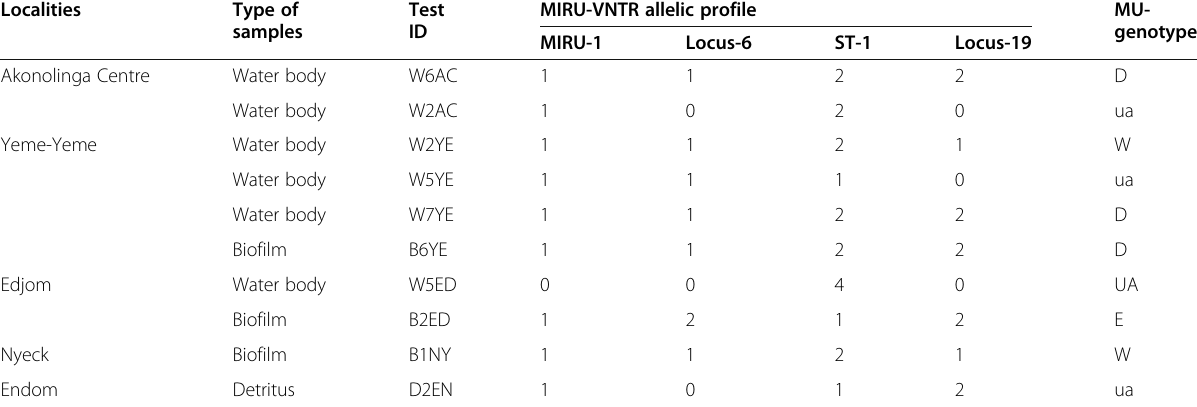
Table 2 VNTR profile of MU isolates detected in various environmental samples